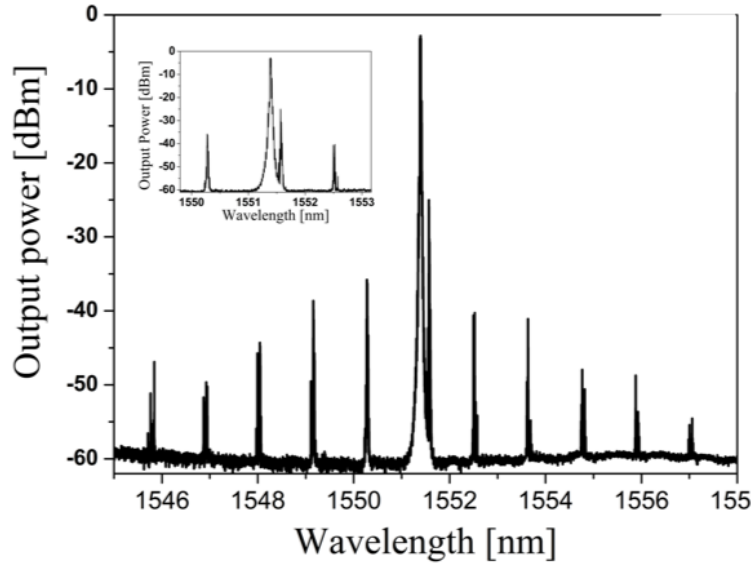
Figure 10. Native Kerr comb and second order SBS in forward direction: pump power 72 mW at 1551,344 nm. (Inset: zoom of the spectrum showing the 2nd order SBS laser line and the first pair of FWM lines) Reproduced with modifications from Ref.